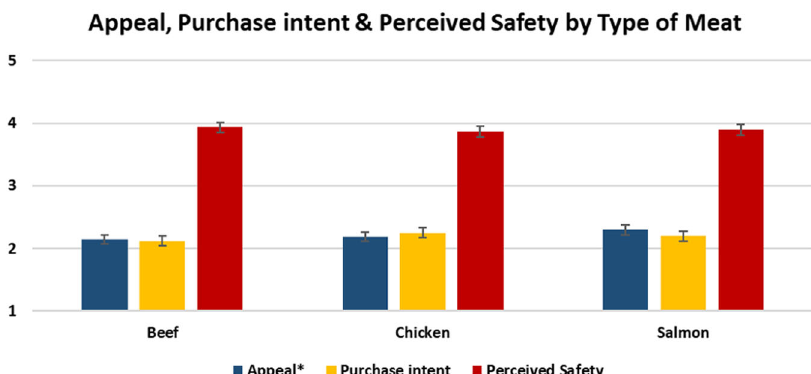
Fig. 10 Appeal, purchase intent, and perceived safety by product type. The graph shows the mean scores with 95% con fi dence intervals for the subjective appeal, purchase intent, and perceived product safety of cell-cultivated meat across experimental conditions by type of meat. Table 7. Multiple linear regression showing signi fi cant demographic predictors of cultivated meat and seafood purchase intent. F(7,2603) = 17.08, p < 0.001 R 2 = 0.044, Adj R 2 = 0.041 Unst. Beta Std. Error Std. Beta